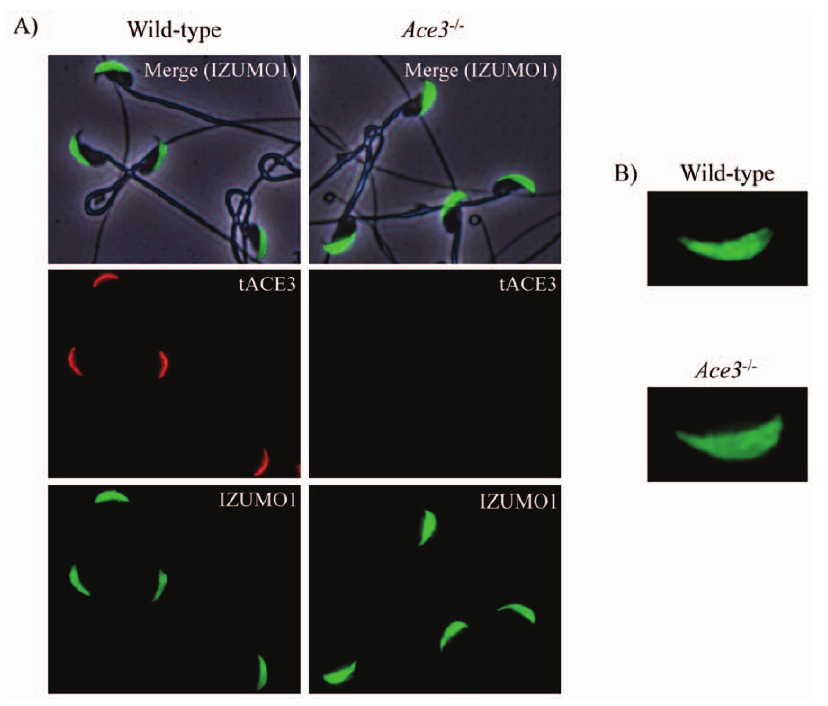
Figure 5. Immnolocalization of IZUMO1 protein in Ace3 2 / 2 sperm. Wild-type and Ace3 2 / 2 sperm were immunostained with 4 m g/ml anti- tACE3 (red) and anti-IZUMO1 (green) antibodies (A). The staining pattern of IZUMO1 in Ace3 2 / 2 sperm showed a significantly broader staining area than that of wild-type sperm (B).